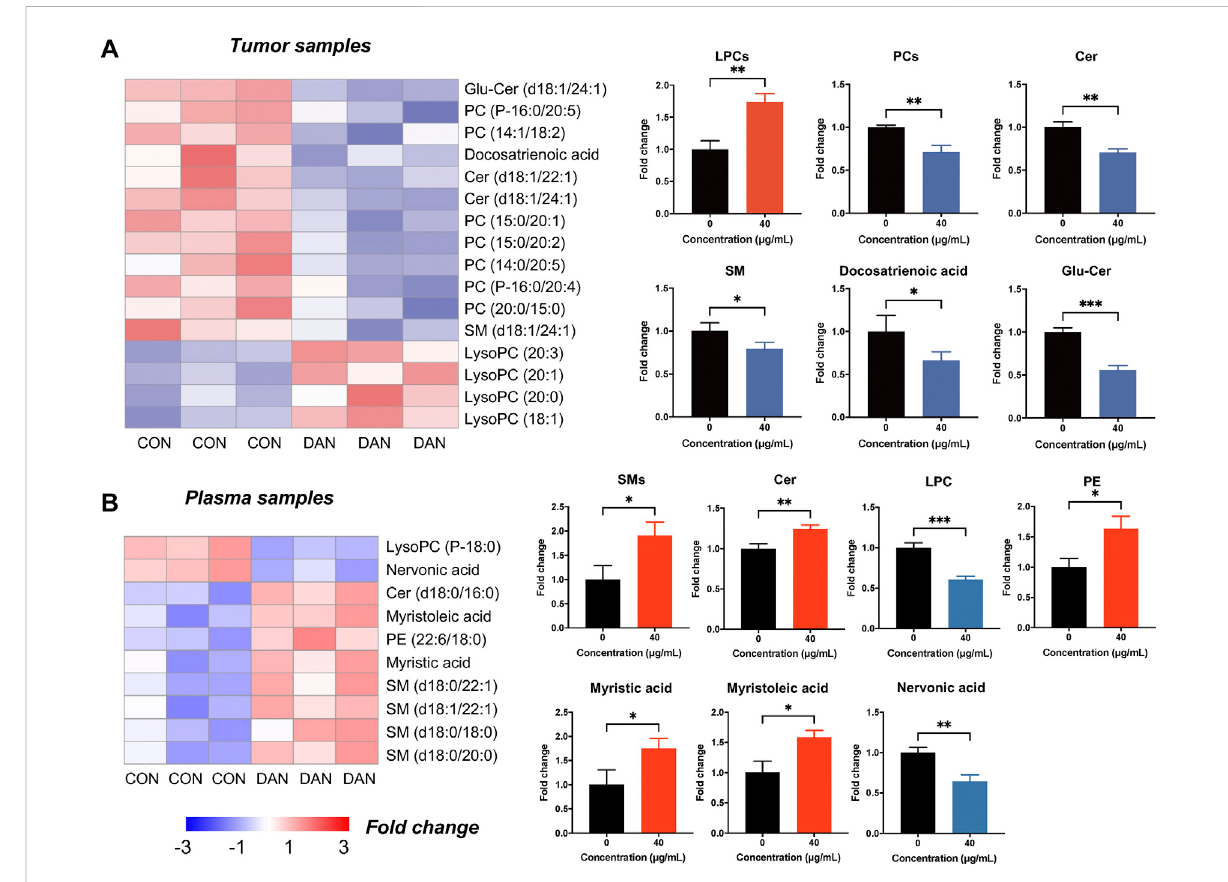
FIGURE 5 Thelipidomicspro fi lesofTNBCtumortissueandplasmaafter dandelionextracttreatment. (A) Theheatmap chartsofthesigni fi cantly changed metabolites in tumor tissue lipidomics. (B) The heatmap charts of the signi fi cantly changed metabolites in plasma